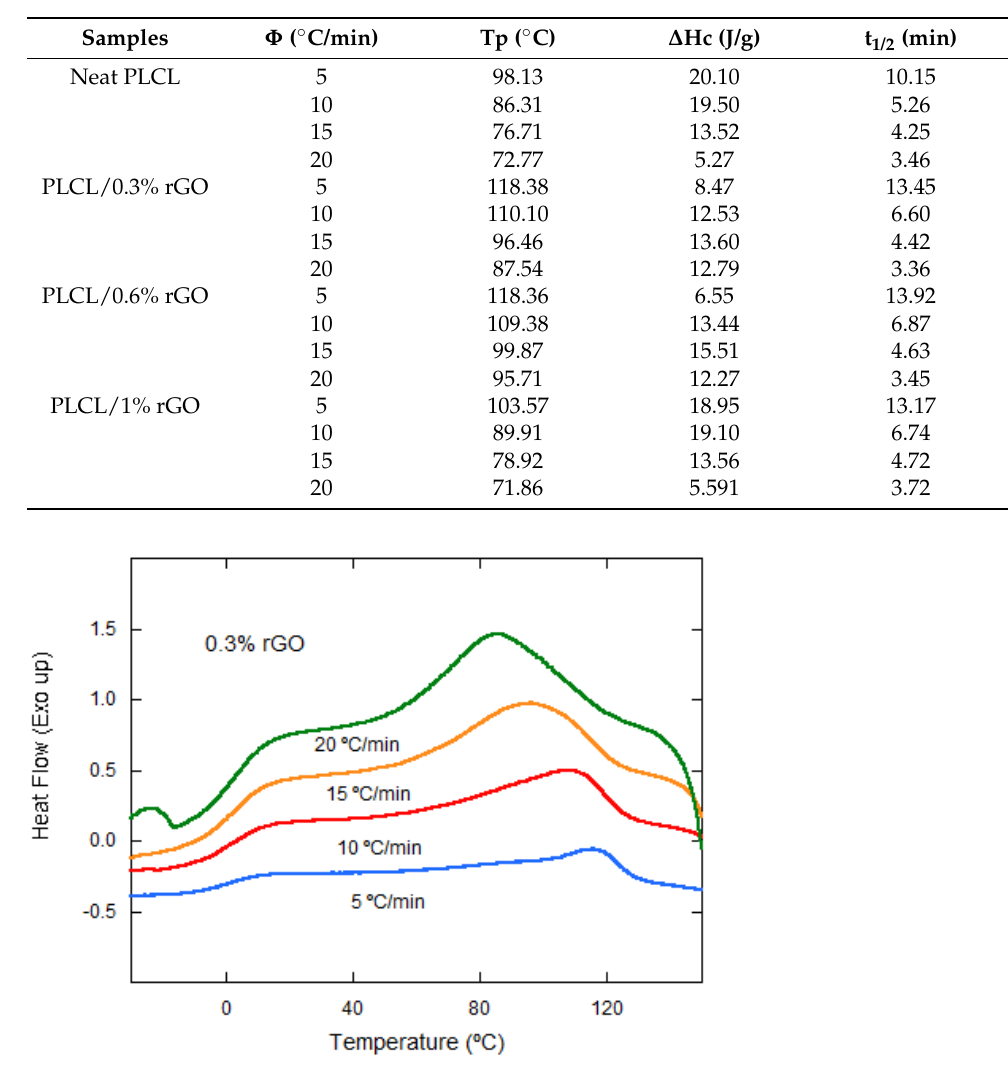
Figure 5. Nonisothermal cold crystallization behavior of PLCL/rGO 0.3 wt% at different cooling rates .